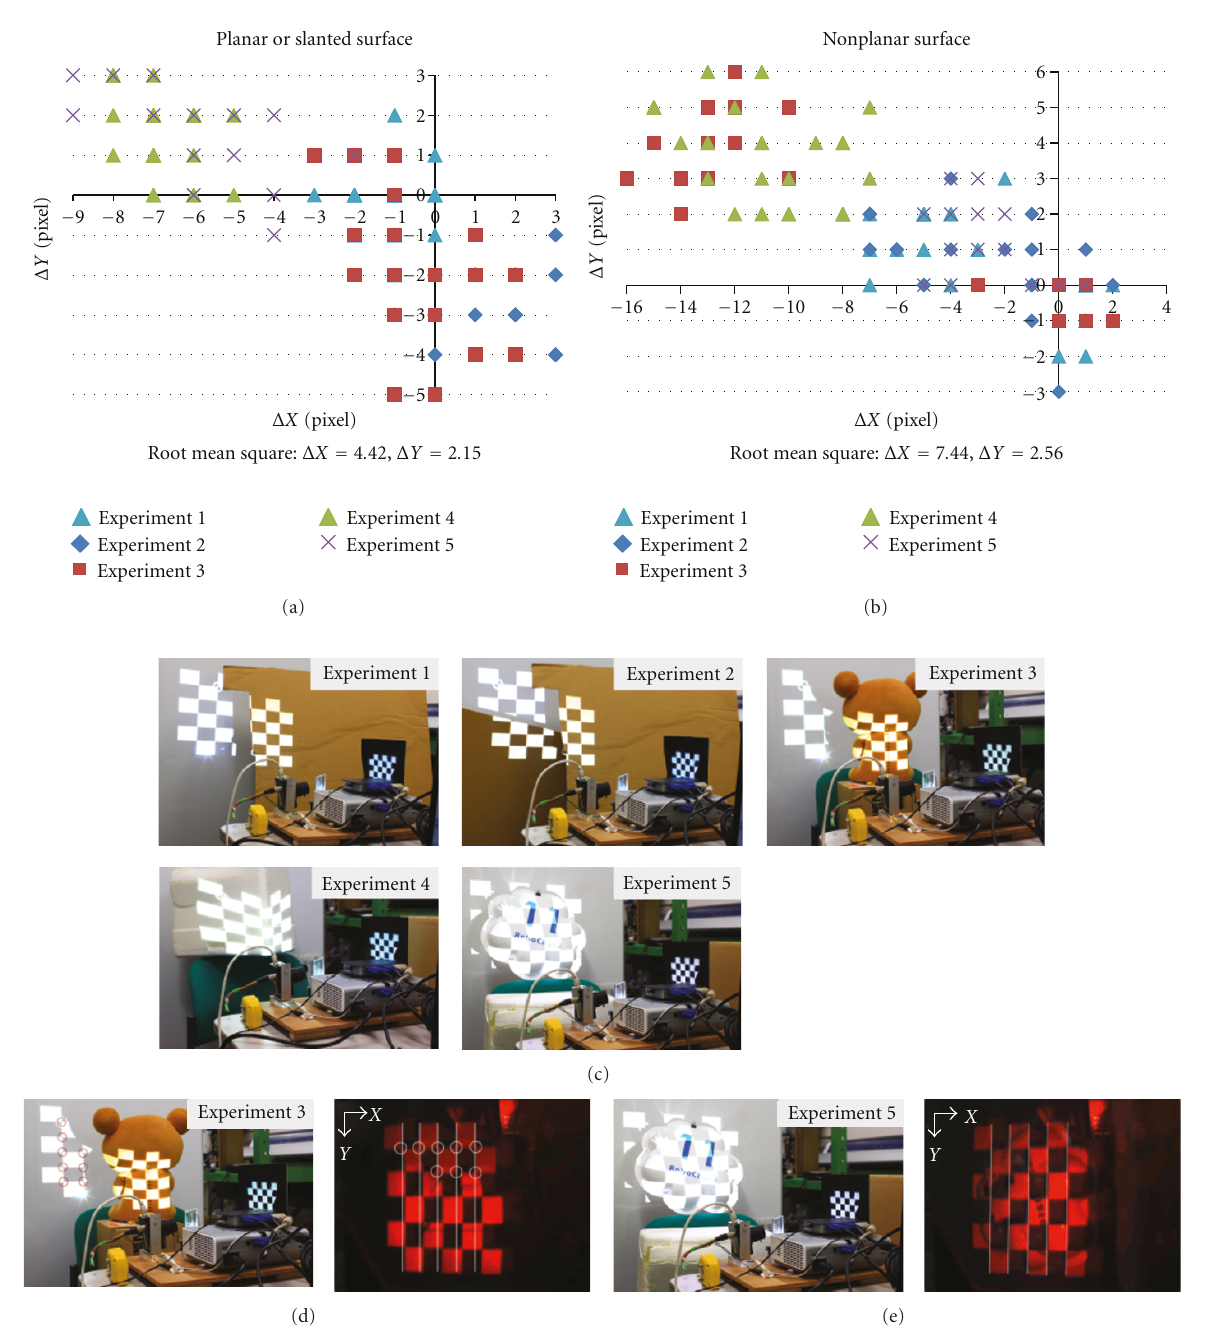
Figure 13: (a) Geometric error (camera coordinates) of the proposed pro-cam geometric calibration approach on planar and slanted surfaces. (b) Geometric error (camera coordinates) of the proposed pro-cam geometric calibration approach on nonplanar surfaces. (c) Snapshots of the nonplanar experimental surfaces. (d, e) are the captured images of the third and fifth nonplanar experiments, respectively.